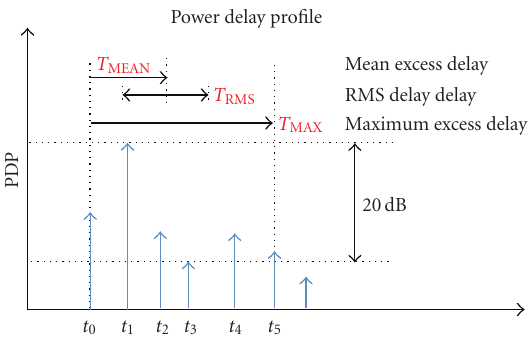
Figure 1: PDP and measured delay